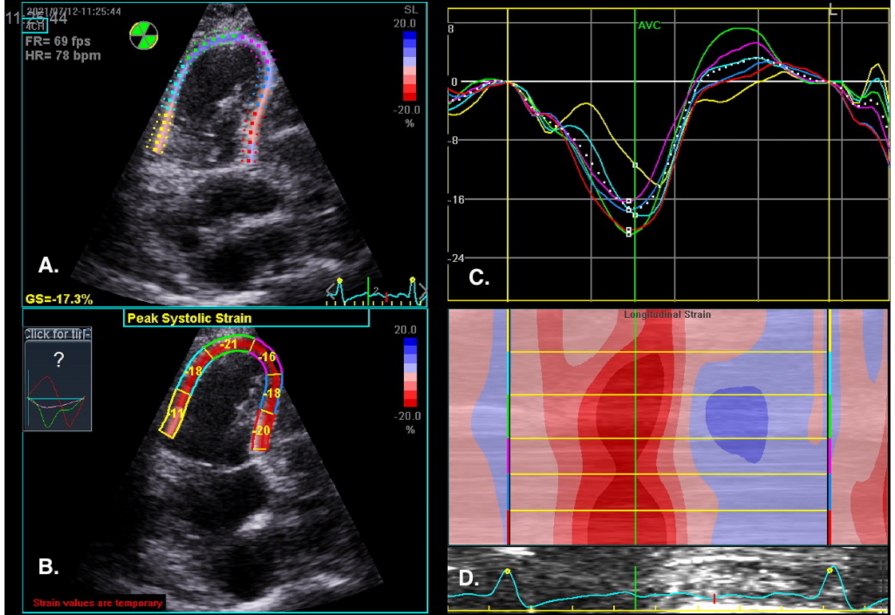
Figure 10. RV regional myocardial contractility (longitudinal strain) assessment by speckle tracking imaging. RV-focused view, 4CH. ( A ) Tracked apical loop with colour coding of the RV free wall and interventricular septum myocardial segments. ( B ) Regional end-systolic strain. ( C ) Segmental strain curves and segmental strain values displayed during the cardiac cycle. Global longitudinal strain at peak strain is visualized with the global strain curve (white dotted line). ( D ) M-mode representation of peak systolic strain. Blue colour- myocardial lengthening, red colour- myocardial